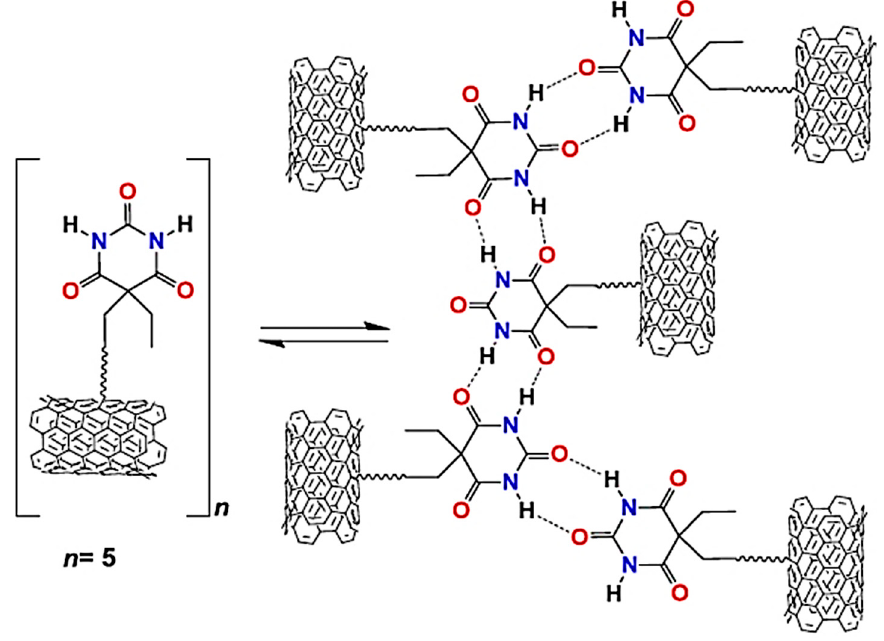
Figure 8. The barbiturate-modified MWCNT for reversible opening and closing of hydrogen bonds during damage and healing event. MWCNT = multiwalled carbon nanotube. Reprinted with permission from [112]. 2019, Elsevier (Creative Commons CC-BY).